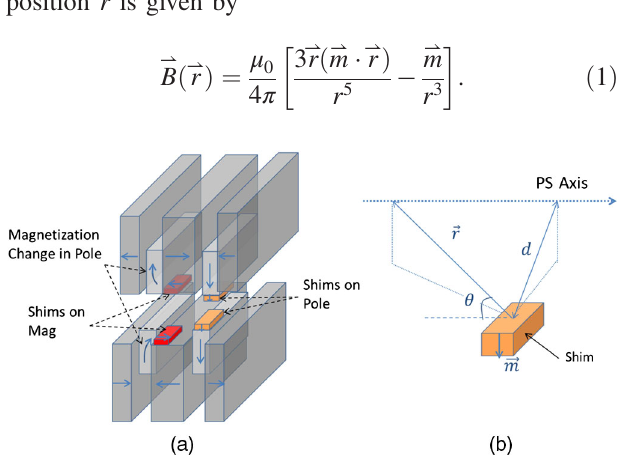
FIG. 4. (a) Magnetic moments in magnets and poles in a hybrid undulator and the induced magnetic moments in shims on magnets and poles. (b) The orientation of the magnet moment vector and its contribution to the field in